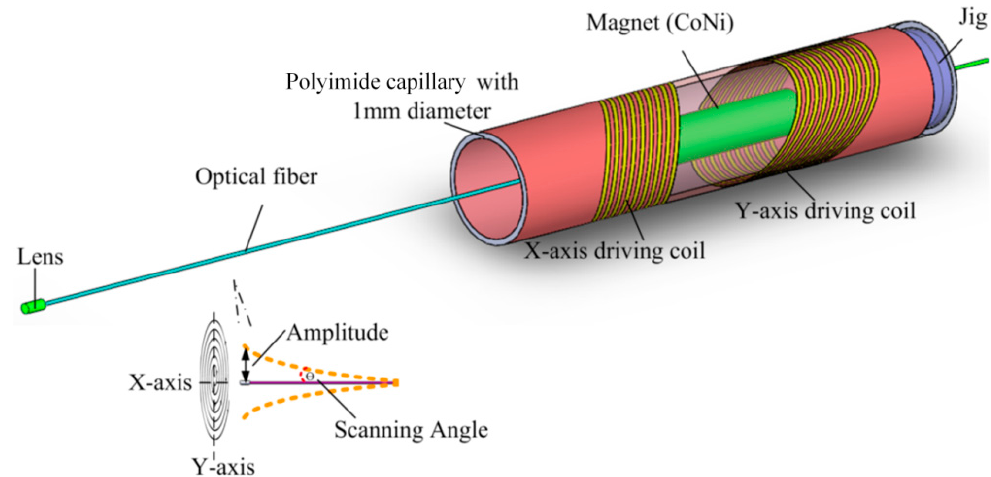
Figure 1. Sketch of proposed single-fiber scanner by electromagnetically driven tilted microcoil to which AC power is supplied.